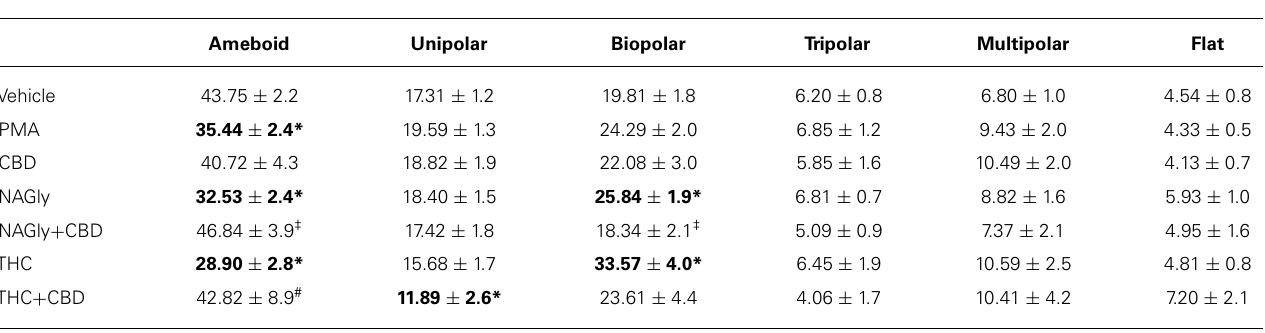
Table 1 | Percentage of BV2 cell morphologies with vehicle and six treatment